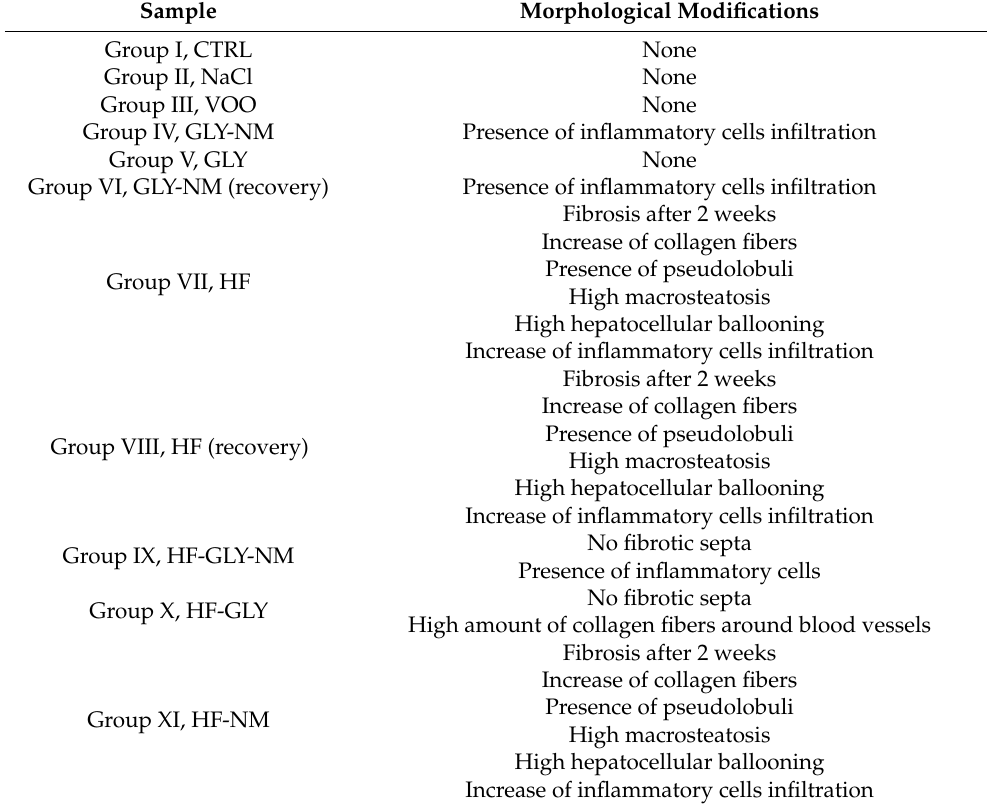
Table 2. Histopathological observations of livers. CTRL (Group I): Control untreated rats allowed free access to food and water. NaCl (Group II): Rats intraperitoneal injected with sterile 0.9% NaCl solution three times a week for two weeks. VOO (Group III): Rats intraperitoneal injected with sterile virgin oil three times a week for two weeks; GLY-NM (Group IV): Untreated rats adminis- tered with encapsulated Galunisertib-LY2157299 (GLY-NMs) (GLY-NMs safety assessment); GLY (Group V), GLY: Untreated rats administered with free Galunisertib-LY2157299 (GLY) alone (GLY safety assessment); GLY-MN (recovery) (Group VI): Untreated rats administered with encapsulated Galunisertib-LY2157299 (GLY-NMs) followed by additional 2 weeks with free access to food and water (GLY-NMs safety assessment); HF (Group VII): Hepatic fibrosis (HF) model; HF (recovery) (Group VIII): HF rats were left to recover for two weeks after the last injection of CCl 4 with free access to food and water (control of immune system responses); HF-GLY-NM (Group IX): HF rats treated with encapsulated Galunisertib-LY2157299 (GLY-NM) (proposed therapeutic model); HF-GLY (Group X): HF rats treated with free Galunisertib-LY2157299 (GLY) (positive control of proposed therapeutic model); HF-NM (Group XI): HF rats were intraperitoneal injected with empty micelles three times